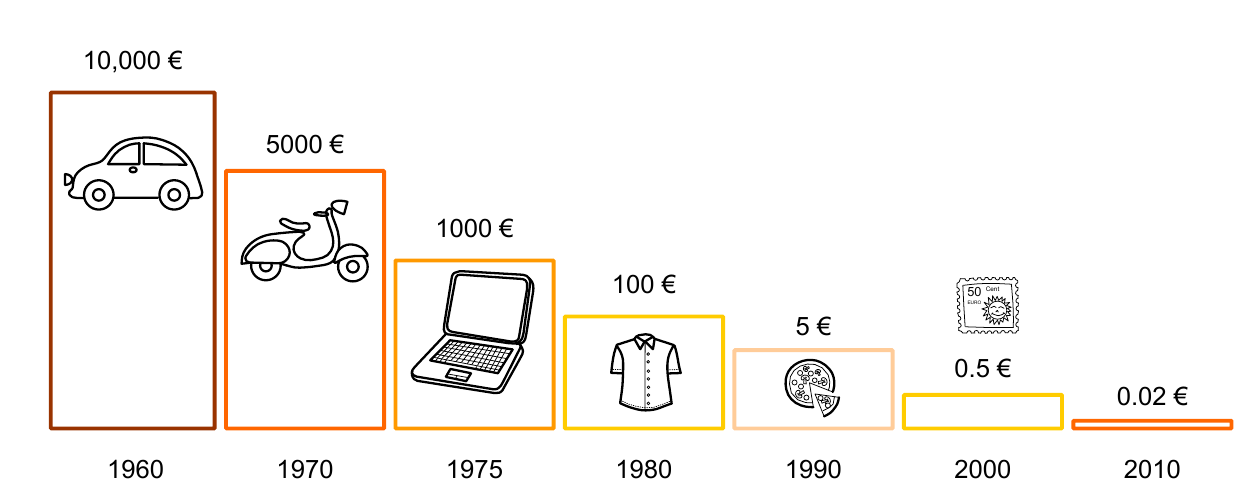
Figure 19. Single-sensor pixel-cost evolution, source [42].